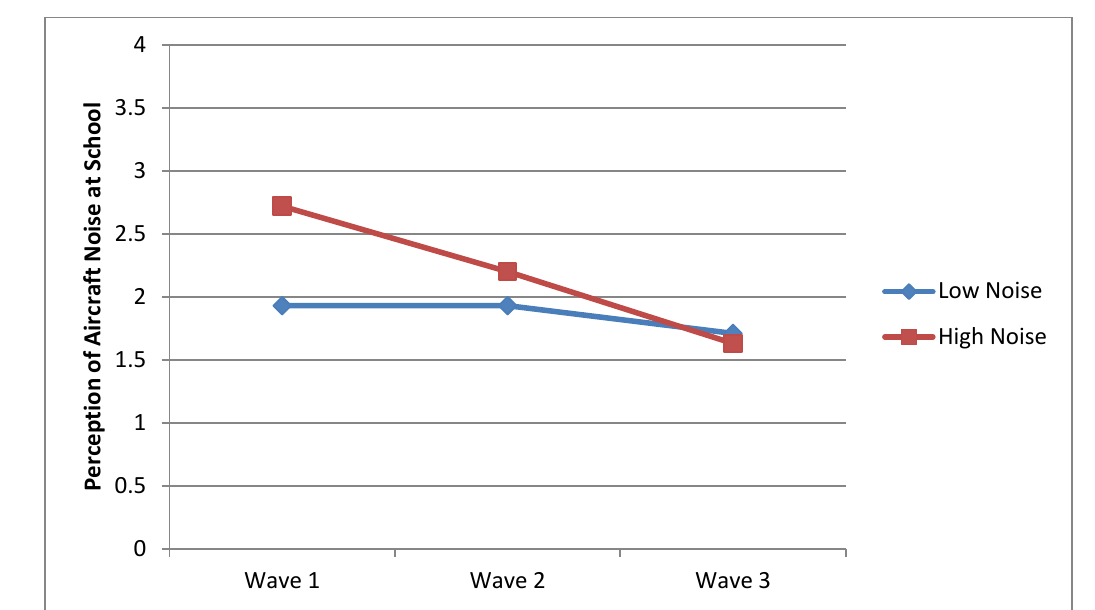
Figure 3. Perception of aircraft noise at